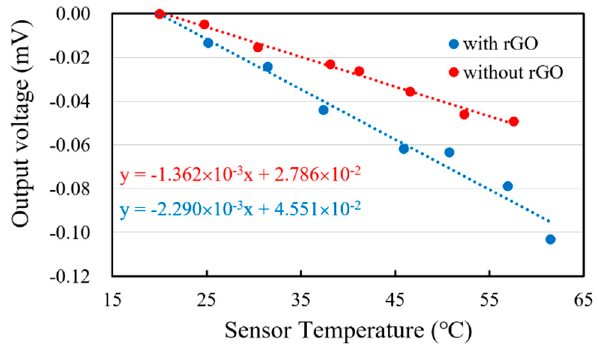
Figure 10. Output voltage vs. temperature of the sensors.